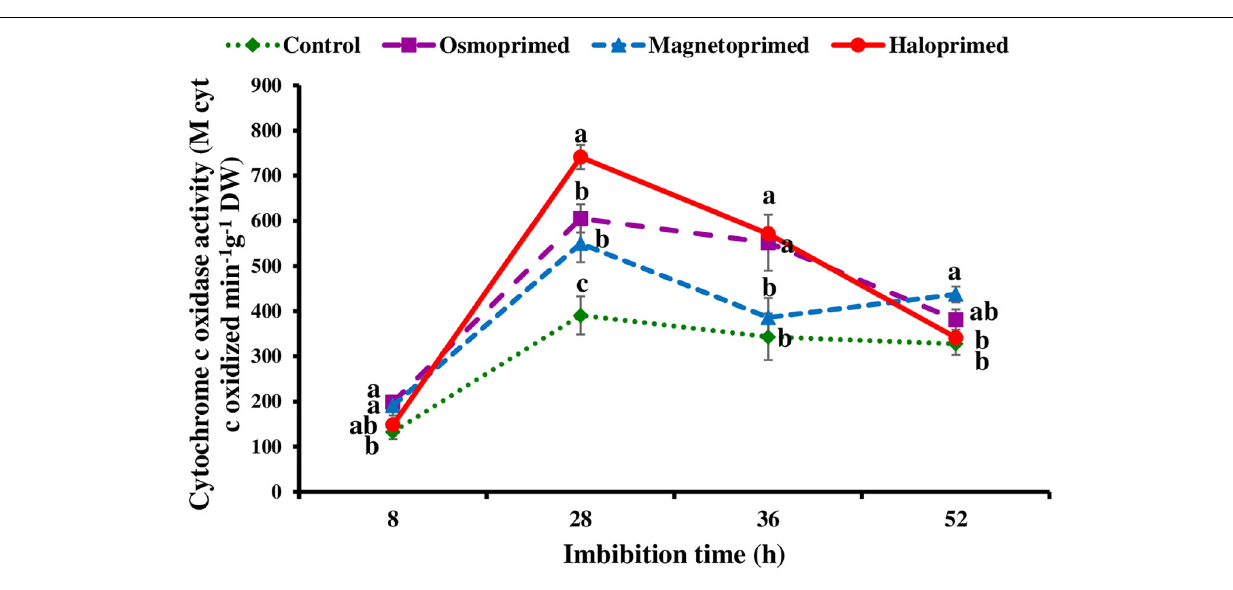
values suggest that germinating seeds have much lower/higher temperature than the surrounding